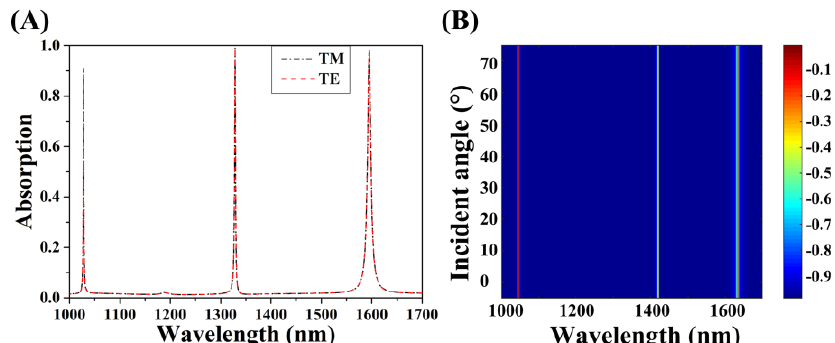
Figure 9. Changes in absorption while varying the angle or polarization of the incident light and keeping the other parameters unchanged. ( A ) The optical absorption of the absorber in TE (the direction of electric field is parallel to y ) and TM (the direction of electric field is parallel to x ) polarization modes. ( B ) Varying the incident angle when the incident light source was in TM polarization mode.